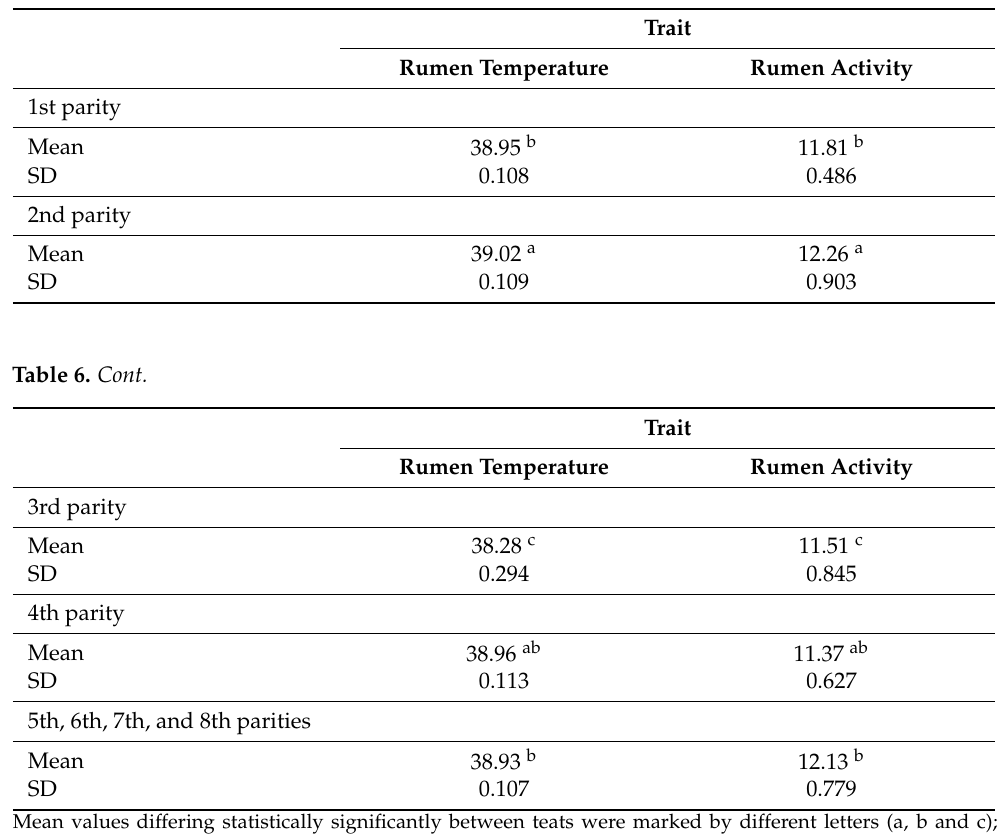
Table 6. Mean and standard deviations (SDs) of considered traits for rumen in the groups designated by parity number in the South Korean summer.